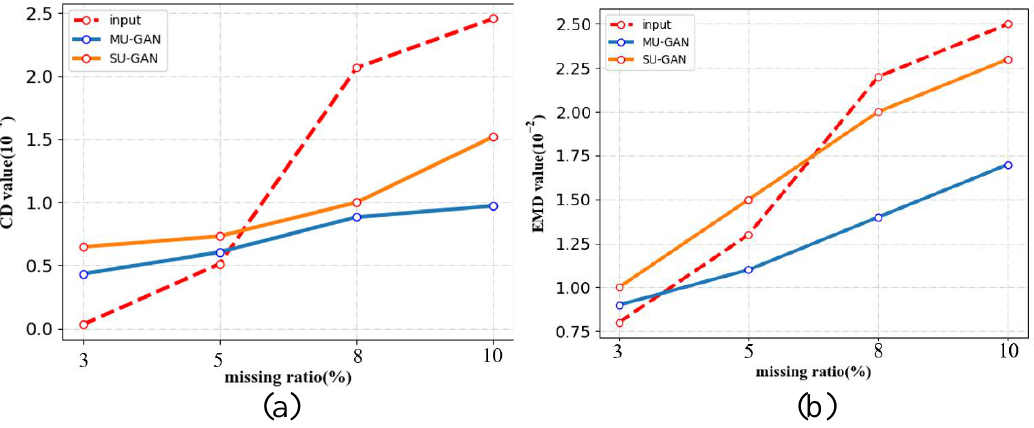
Figure 9. ( a ) the CD value with different hole sizes; ( b ) the EMD value with different hole sizes.